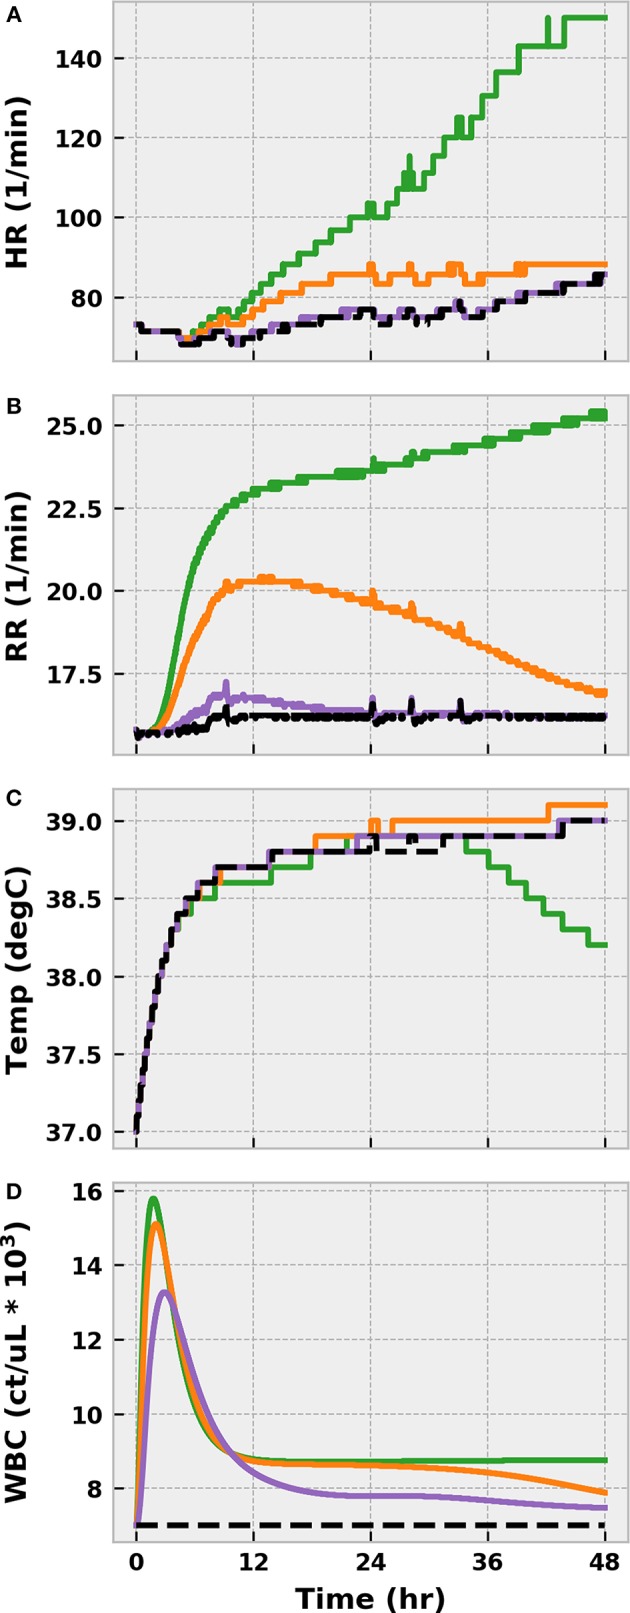
The progression of physiological markers of inflammation when the BioGears Infection action is simulated for 48 h at three different severities: mild (purple), moderate (orange), and severe (green). (A) HR, (B), RR, (C) temperature, and (D) white blood cell count (WBC) are compared against a no-infection baseline simulation in which the same water and meal consumption schedule is followed (Black). The combination of tachycardia, tachypnea, fever, and leukocytosis in the Severe case all indicate Systemic Inflammatory Response Syndrome (SIRS). Symptoms in Mild and Moderate cases show minor deviations from baseline physiology that, for the most part, resolve over 48 h. The exception is core temperature, which increases across all scenarios and decreases more rapidly in the presence of severe infection. This outcome outcome likely indicates a minor setpoint issue in the BioGears temperature regulation model. The late decline in the severe case might be attributable to decreased blood flow to the skin, which is a factor in temperature conductance between the core and the environment in BioGears.